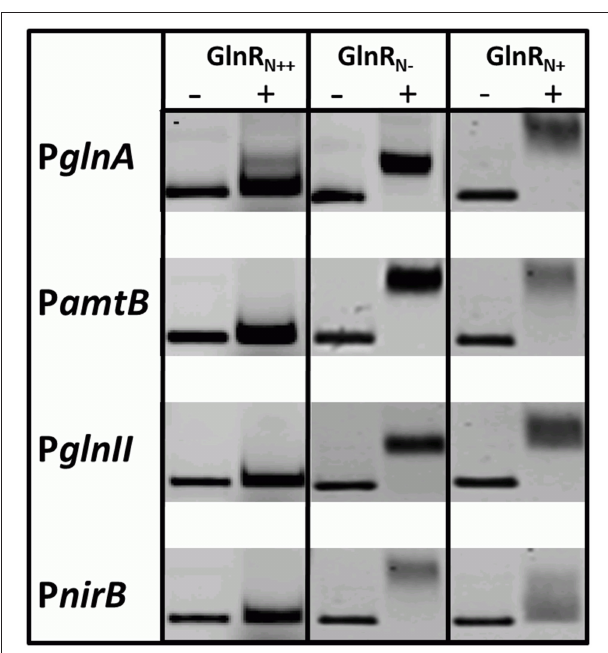
FIGURE 3 | EMSAs demonstrating different binding behavior of Strep-GlnR depending on differential modification patterns. Lane ( − ), control, promoter regions of the known GlnR target genes (Cy5—labeled probe without Strep-GlnR protein). Lane ( + ), Cy5—labeled probe with 4 µ g of the Strep-GlnR N + from complex, rich condition (phosphorylated on the six Ser/Thr residues and acetylated on the one Lys residue), Strep-GlnR N − from nitrate limited conditions (acetylated on four Lys residues), and Strep-GlnR N + from the nitrate excess conditions (acetylated on four Lys residues and additionally phosphorylated on two Ser/Thr residues). The differential modification pattern of Strep-GlnR was confirmed by LC-MS/MS prior EMSAs. EMSAs were performed in the presence of the 300 × excess of the unlabeled, unspecific salmon sperm DNA. M. smegmatis , A. mediterranei , and S. erythraea (Tiffert et al.,